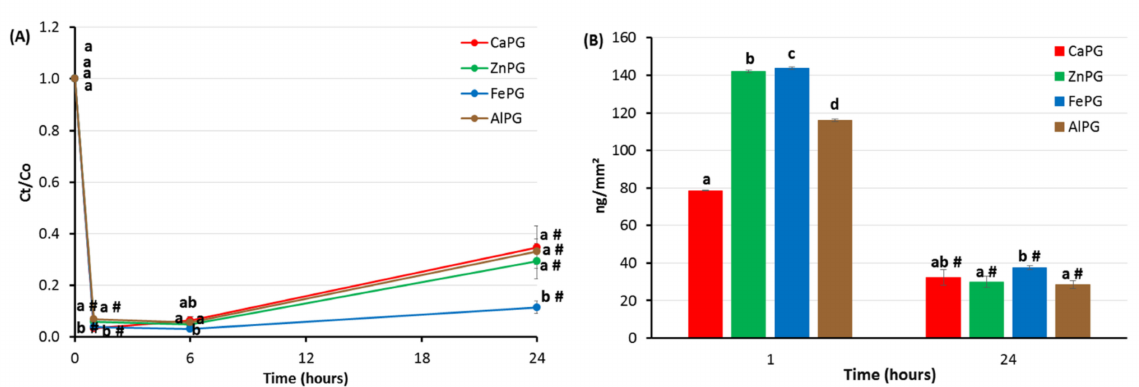
Figure 5. The lipopolysaccharide (LPS) adsorption by CaPG, ZnPG, FePG, and AlPG beads incubated for 24 h in RPMI-1640 medium supplemented with 10% FBS. Adsorption is expressed as the relative LPS concentration Ct/C0 ( A ) and as LPS adsorption per unit surface area ( B ). The data are presented as the mean ± SD ( n = 5). Different letters indicate significant differences between pectin gel beads prepared with different cations ( p < 0.05). # p < 0.05 vs. previous time point. C0 and Ct are the initial and remaining concentrations of LPS in solution at different time points after incubation, respectively.